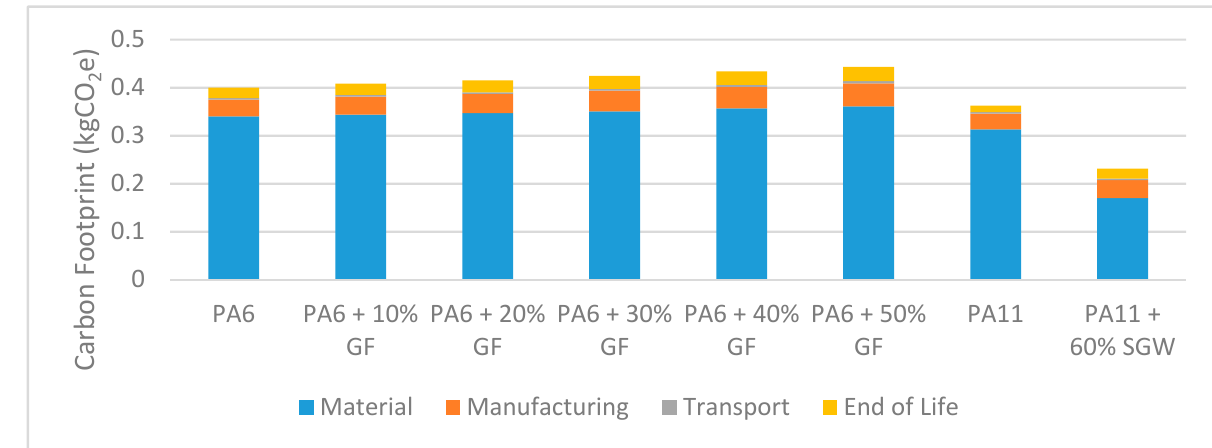
Figure 7. Carbon footprint for a pedal with a 10-year lifespan. Table 4. Carbon footprint (kg CO 2 ) by composite and life cycle analysis (LCA) stage with a life expectancy of 10 years.